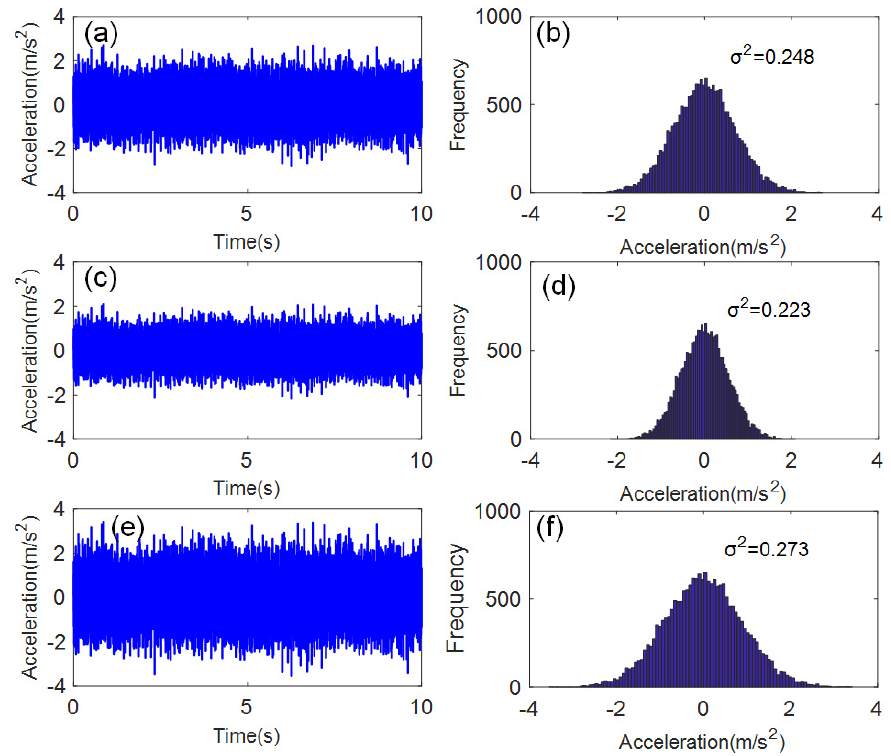
Figure 15. Gaussian random noises for robustness evaluation; ( a , b ) original extracted from the acceleration of unsprung mass, ( c , d ) less contaminated, ( e , f ) more contaminated.